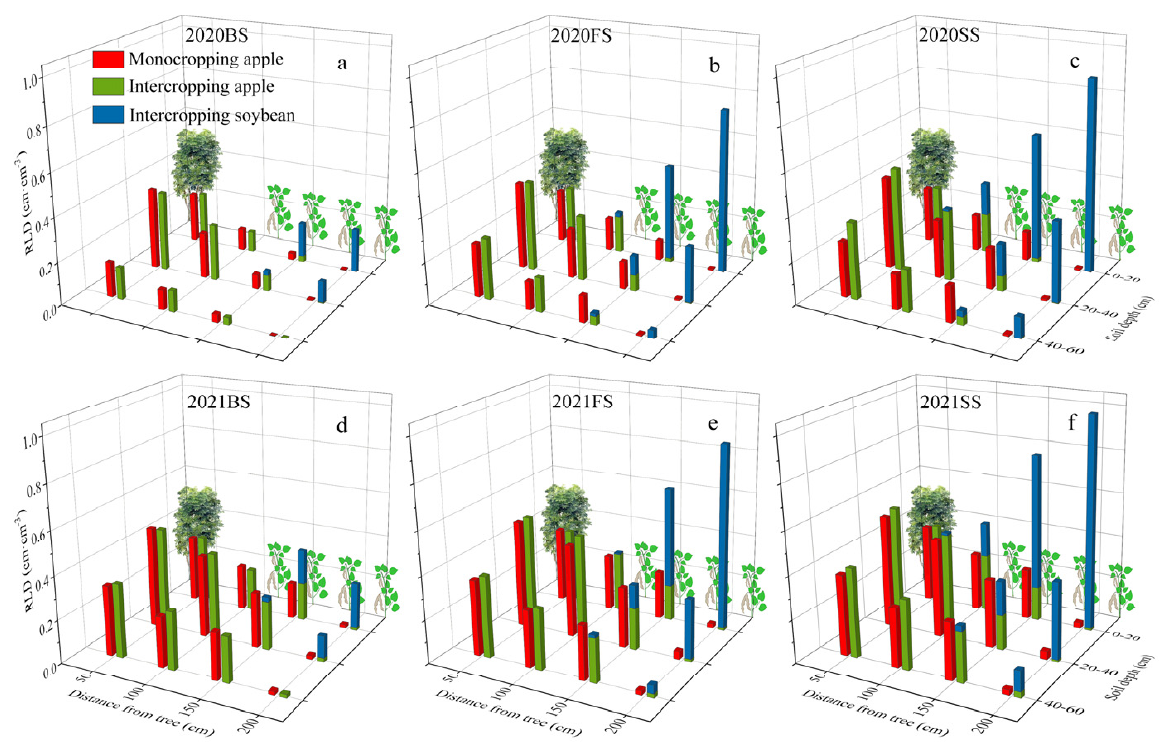
Figure 3. Two–dimensional fine root length density distribution in different growth stages in MA and AS systems. BS: branching stage (left: a , d ), FS: flowering-podding stage ( b , e ); SS: seed filling stage (right: c , f ); in the 2020 ( top ) and 2021 ( bottom ) seasons.